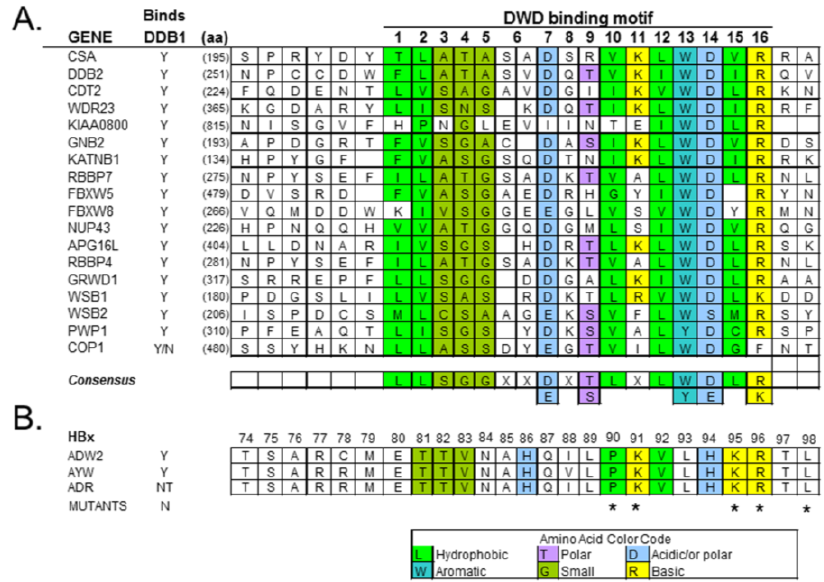
Figure 4. DDB1 binding motif found in DCAFs. ( A ), A DDB1-WD40 box (DWD)